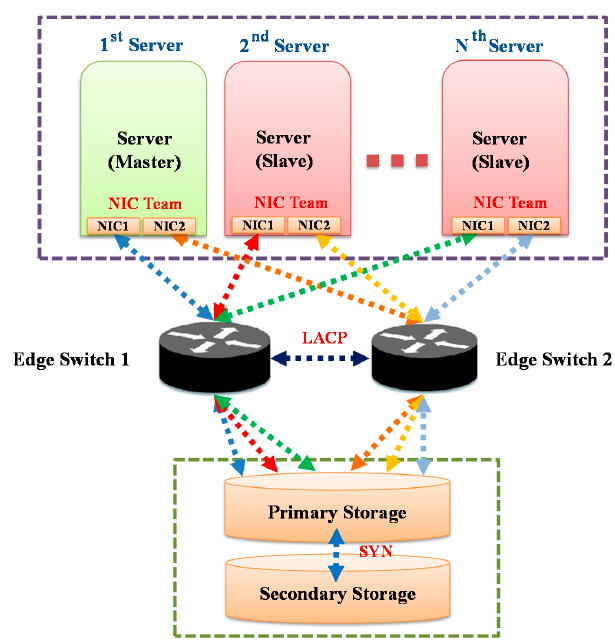
Figure 3. Cloud computing environment.